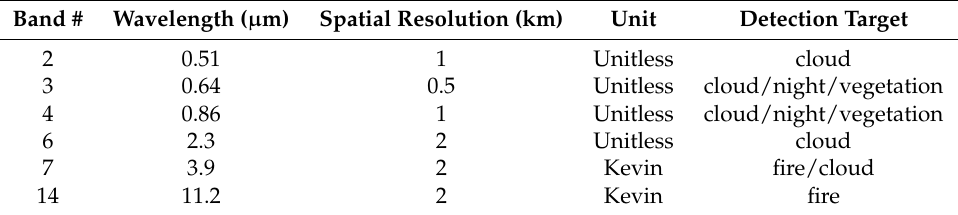
Table 2. Bands of Himawari-8 imagery used for hotspots detection.